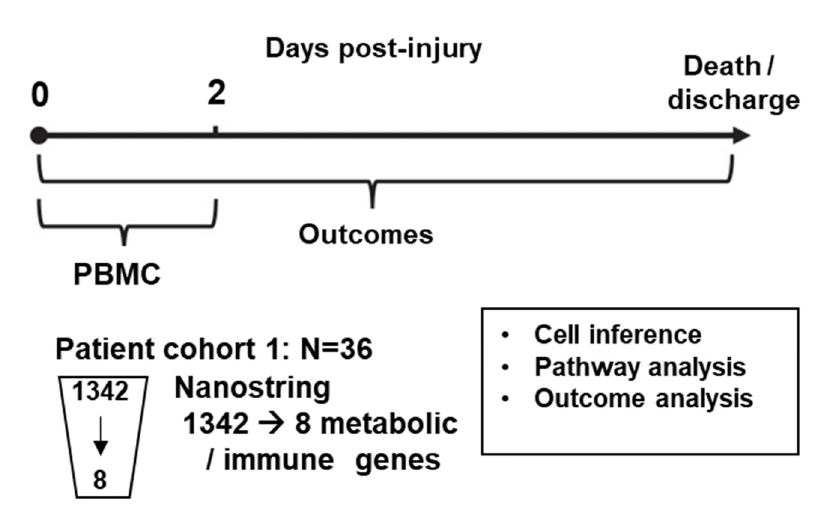
Figure 1. Overall experimental plan. Table 1. Patient demographics.